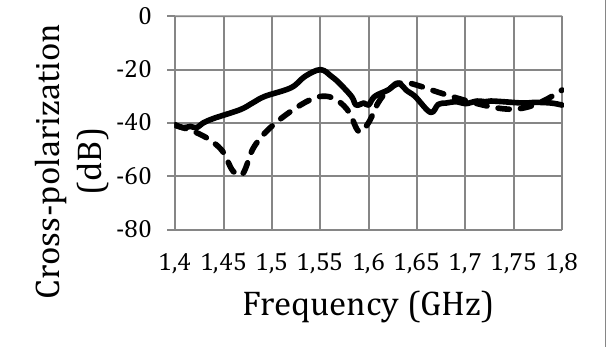
Fig. 12. Polarization ratio vs. frequency: solid – measured, dashed –